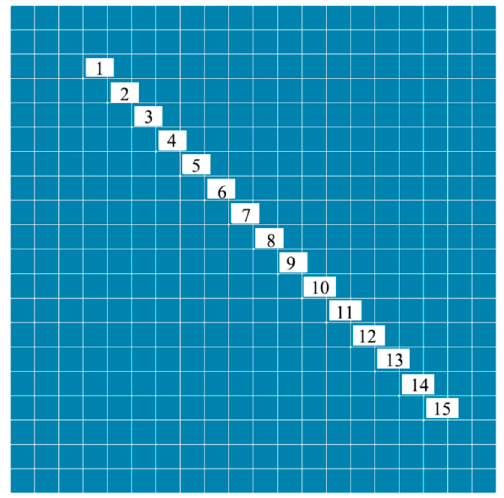
Figure 9. Node location on rigid plate.